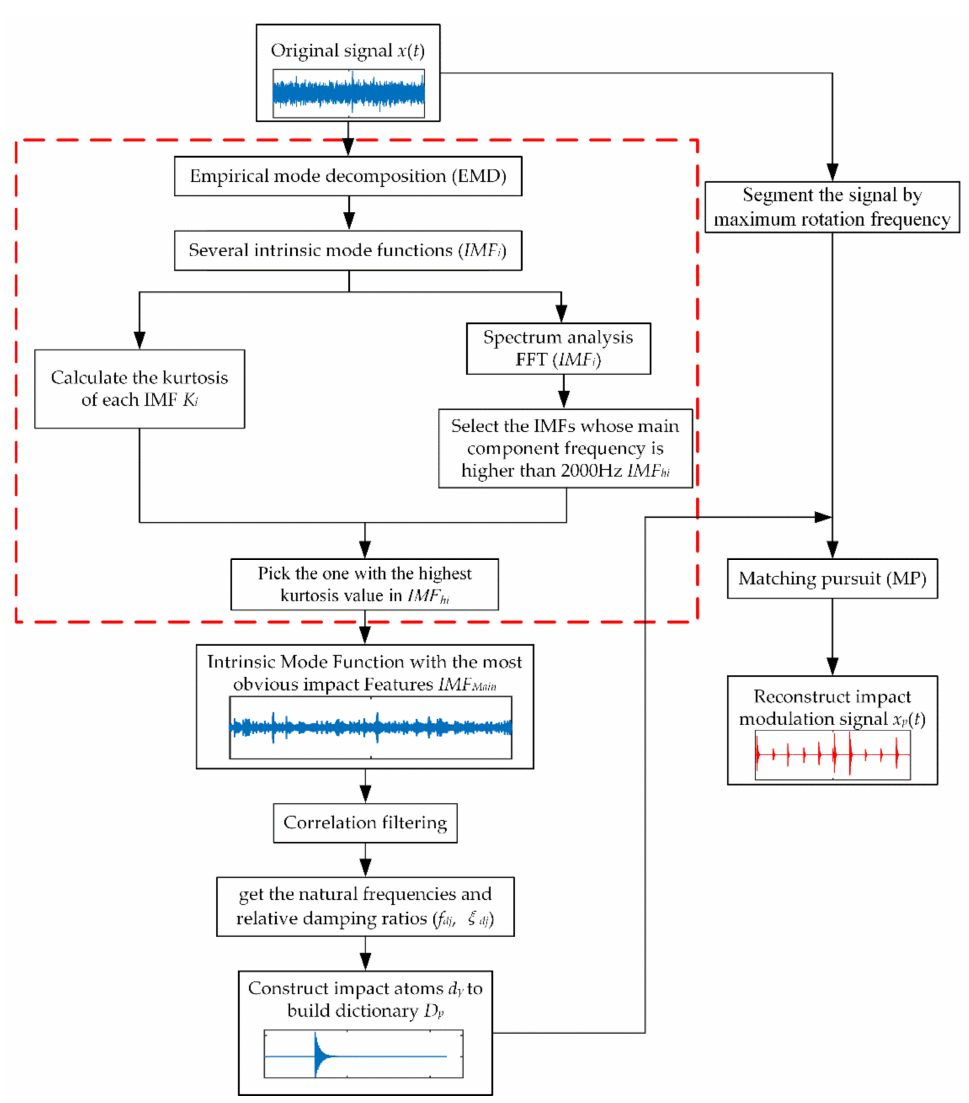
Figure 1. The flowchart of the proposed impact feature extraction method for gear local fault